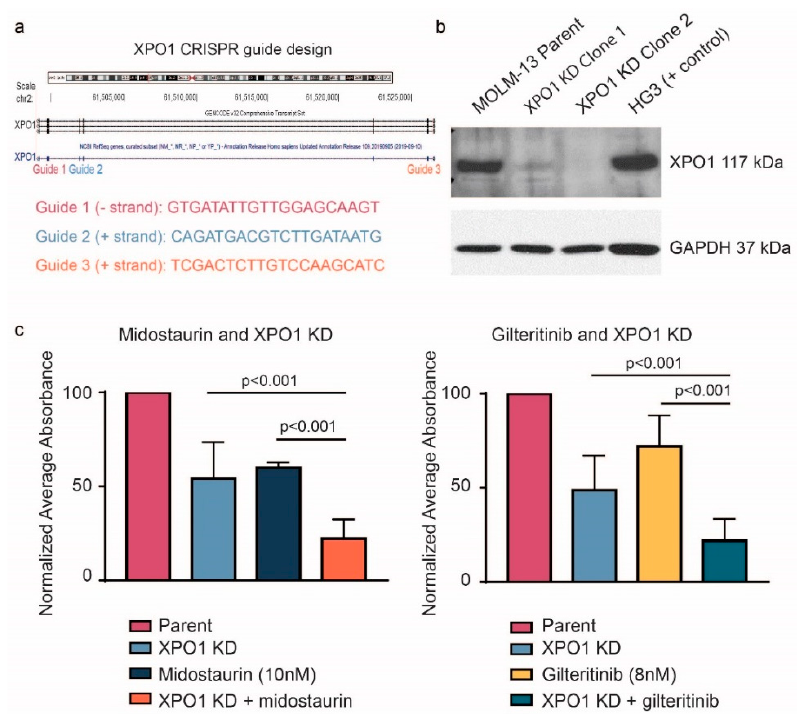
Figure 2. Genetic validation of XPO1 as a cotarget with FLT3. ( a ) Design of three guides targeting XPO1 used to knock down XPO1 expression in MOLM-13 cells. ( b ) Immunoblot analysis showing protein expression of XPO1 in MOLM-13 cells, XPO1 knockdown (KD) cell lines, and HG3 (positive control). ( c ) MOLM-13 parent cells and XPO1 knockdown cells were treated with 10 nM midostaurin or 8 nM gilteritinib for 48 h and proliferation changes compared. For each knockdown experiment, conditions were compared with each clone separately and then the results pooled together across clones to get an average e ff ect ( p < 0.001 where